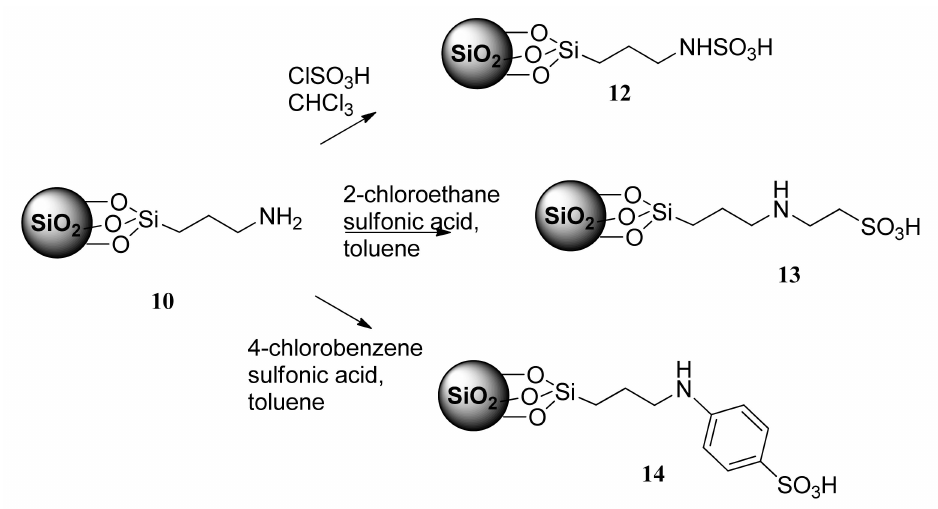
Figure 5. Different catalysts containing both the sulfonic and the amino functions synthesized by Beejapur et al.